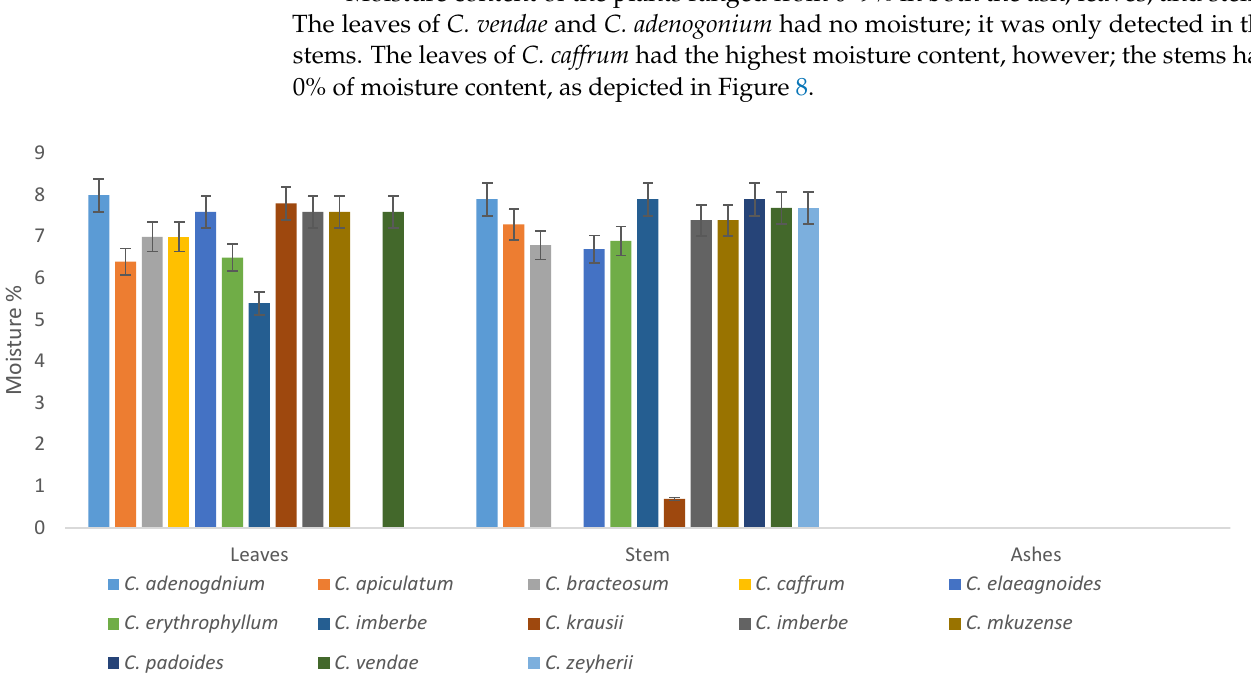
Figure 8. Moisture content (%) of the leaves and stems of the Combretum plants. The protein content in the leaves ranged between, 2 and 14.4%, stems 4.04 and 7.66%, while the ashes contain protein in the range of 0.29–17.1%, as depicted in Figure 9. Gener- ally, the leaves had higher protein content compared to the stems and ashes of other spe- cies. However, the protein contents of the C. elaegnoides and C. padoides were interestingly high. Figure 9 . Protein percentage of the leaves, stems, and ashes of the Combretum species. All the plants had appreciable amounts of energy, with C. adenogdnium exhibiting the highest concentrations for both leaves and stems, as illustrated in Figure 10. The ashes C. erythrophyllum had the lowest energy overall.